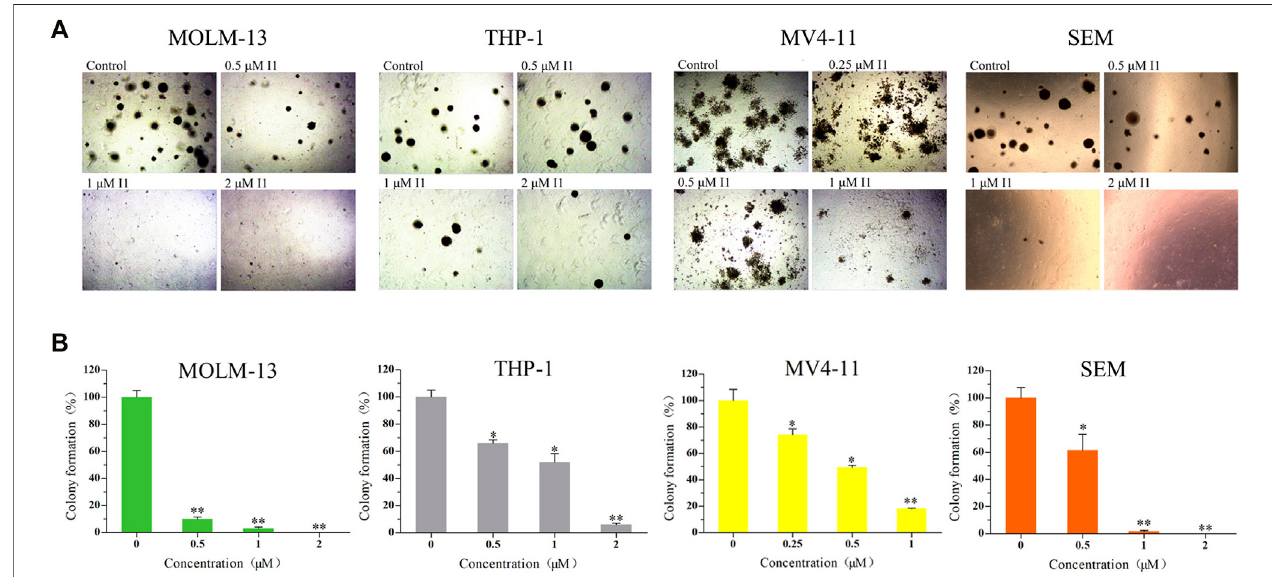
FIGURE2| I1suppressed thecolonyformationofMOLM-13, THP-1, MV4-11and SEMcells. (A) CellsweretreatedwithI1at theconcentrationsof0.25 – 2 μ Mfor 15 daysthenthecellmorphologywasobservedunderlightmicroscopy. (B) Graphbarsexhibitedthestatisticalanalysisofthenumberofcolonies(* p < 0.05,** p < 0.01). The colony formation assay was performed three